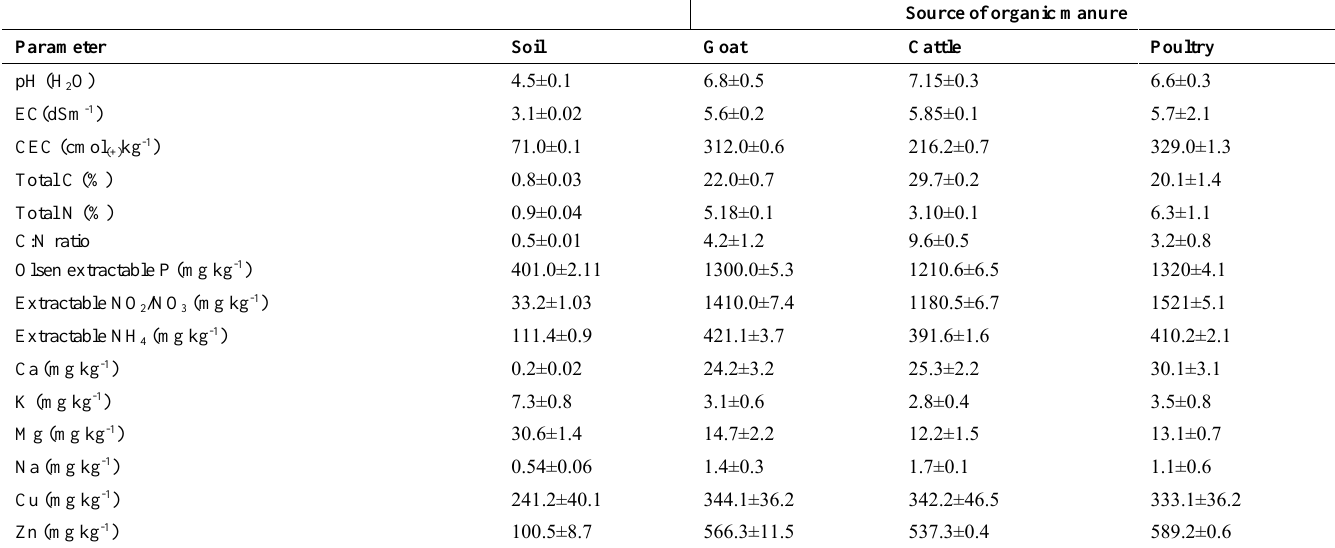
Table 1. The initial chemical properties of the soil at the at Seke Teachers College (STC), experimental field and organic manures used in the study